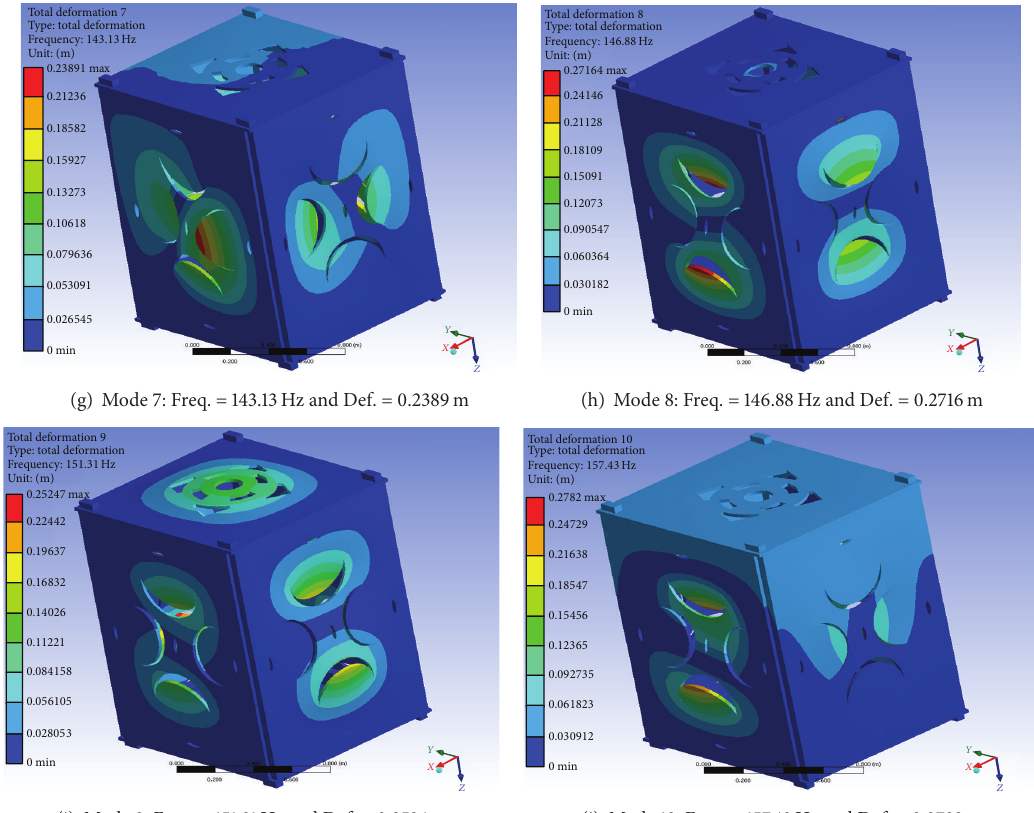
Figure 3: Ten modal shapes for different frequency values.